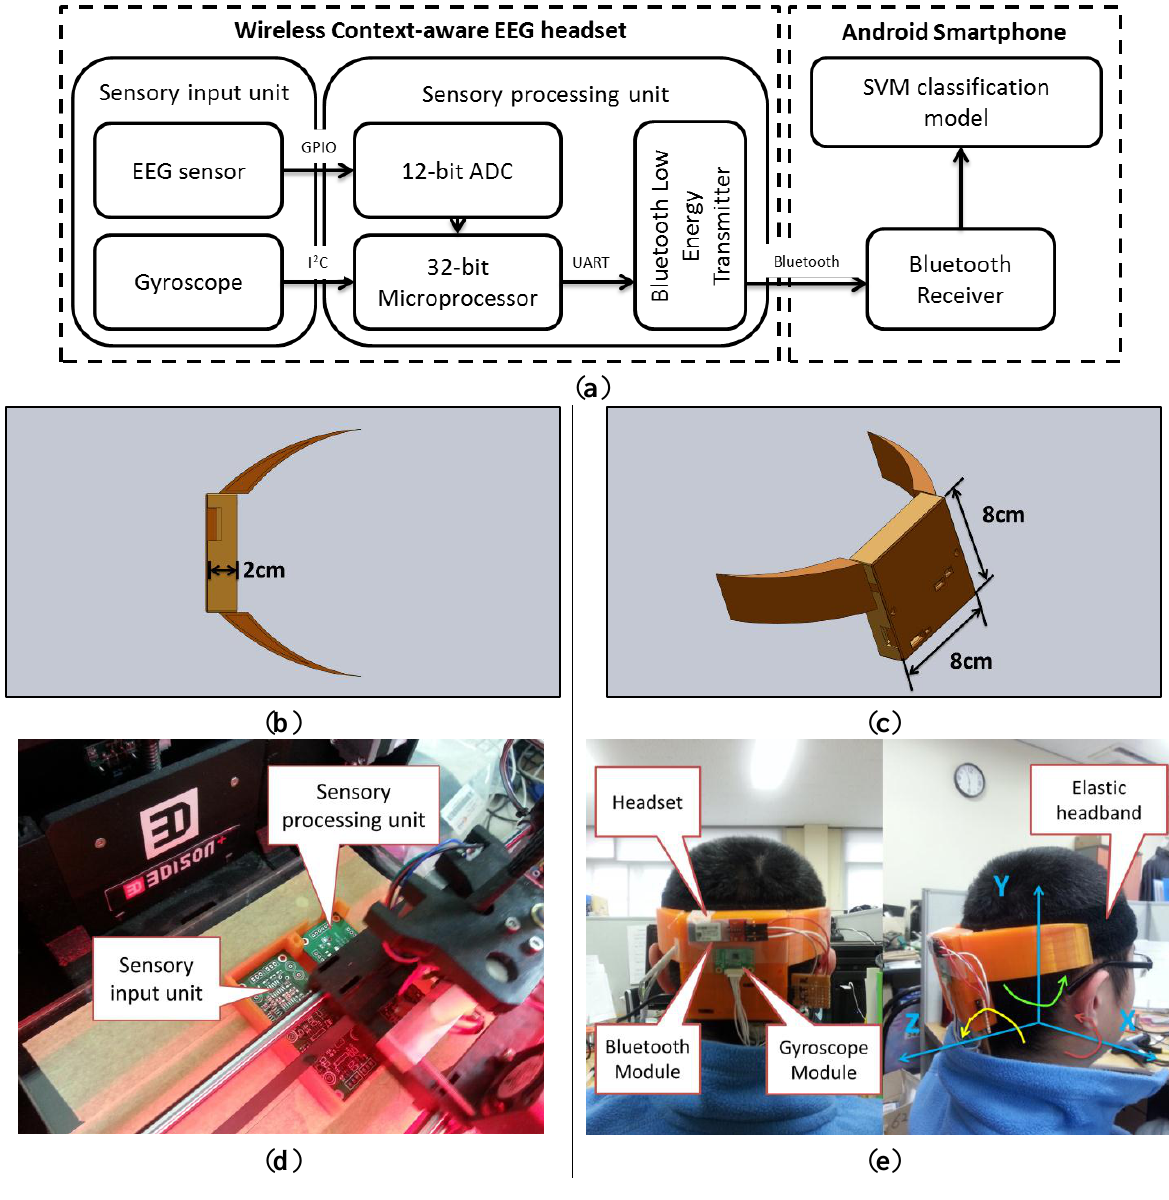
Figure 1. ( a ) Block diagram of the proposed system; ( b ) The top view of the designed headset; ( c ) The full view of the headset; ( d ) The fabricating procedure using 3D printer; ( e ) The fabricated headset